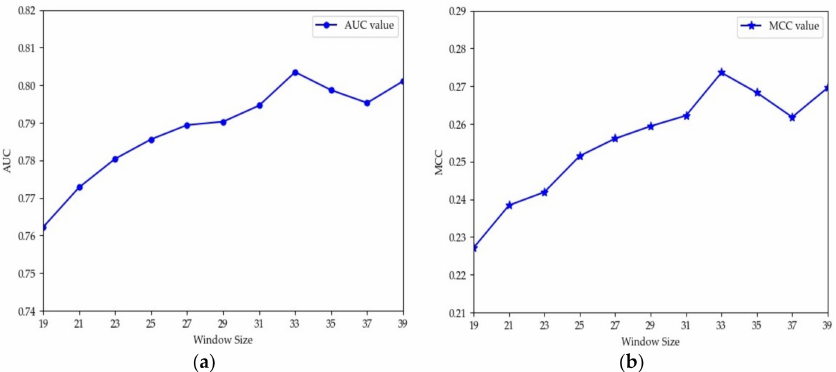
Figure 4. AUC and MCC values vary with different window sizes for 10-fold cross-validation: ( a ) the values of AUC under different window sizes; ( b ) the values of MCC under different window sizes.